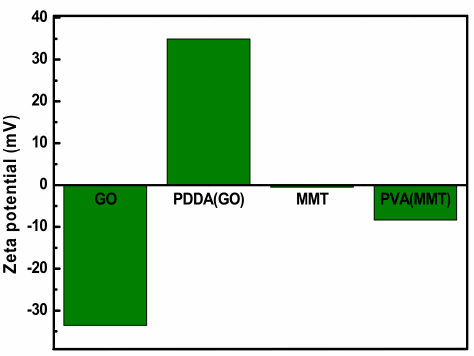
Figure 2. Zeta potential values of the GO, PDDA (GO), MMT, and PVA (MMT)